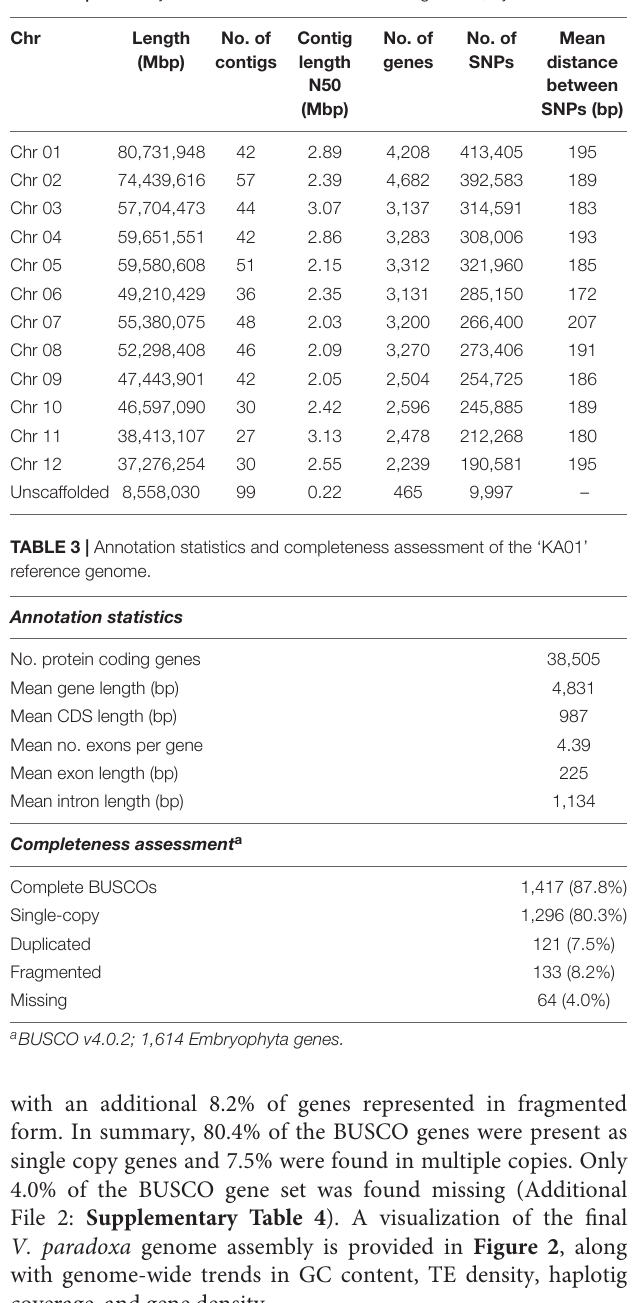
TABLE 2 | Summary statistics of the ‘KA01’ reference genome, by chromosome.